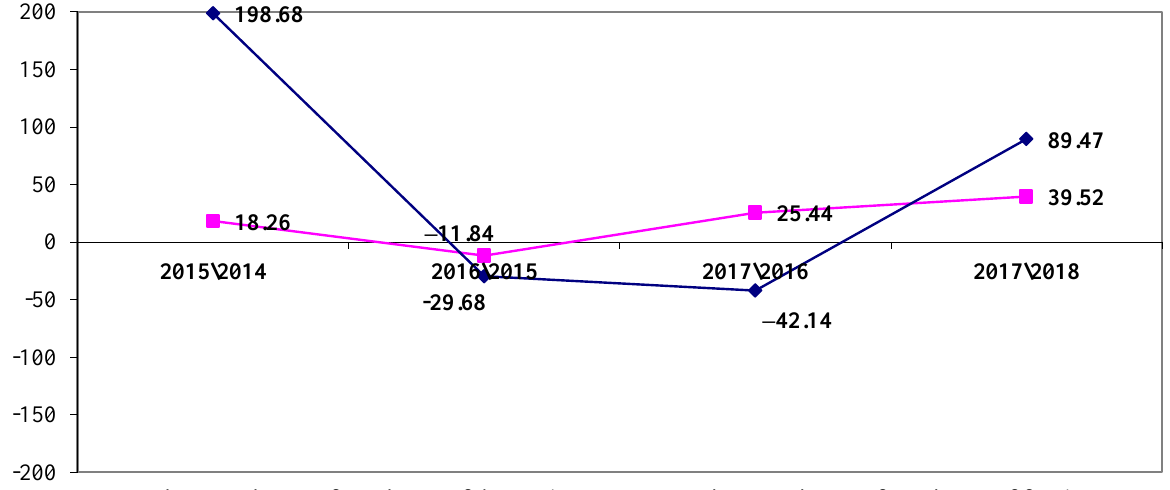
Fig. 6. The dynamics of growth rates of purchase costs on anti-TB D in the context of domestic and foreign production